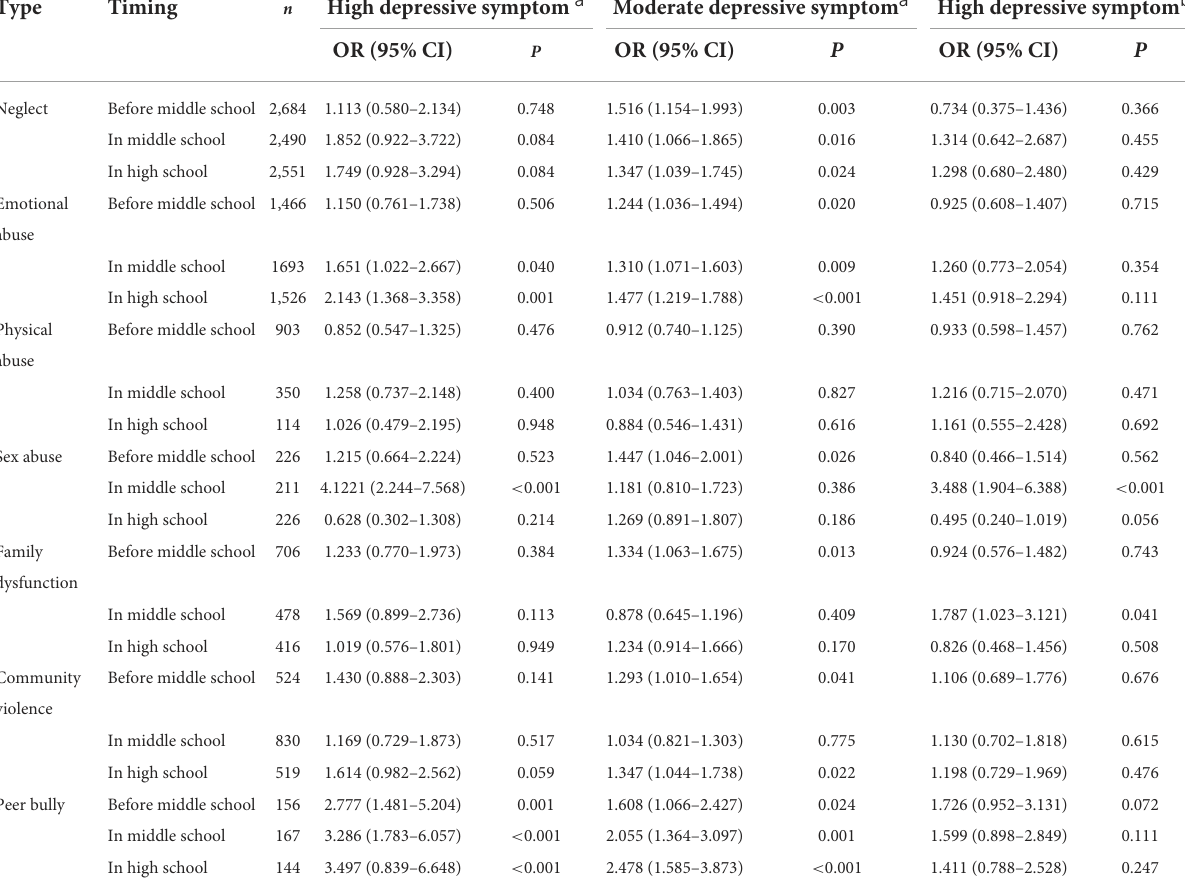
TABLE 2 Logistic regression models of depressive symptom trajectories by ACEs types and timing (Reference: No